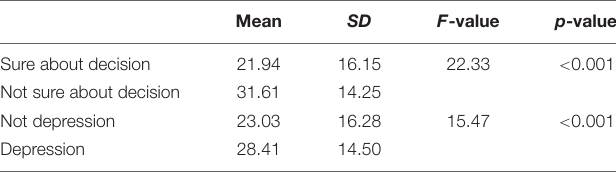
TABLE 4 | The results of known-group validity of the DRSc.